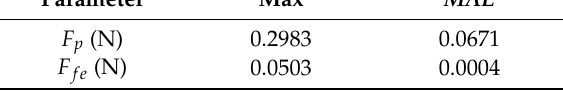
Table 1. The resulted iterative learning control (ILC) quality parameters in the simulation.